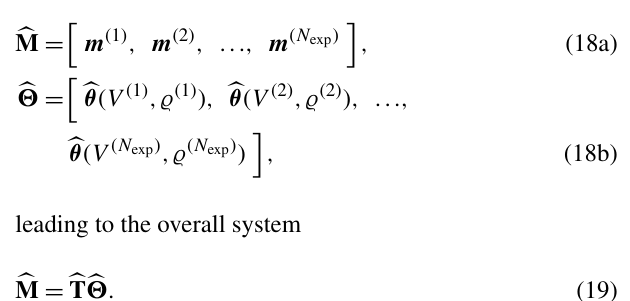
Figure 2. Behavior of two load sensitivities as functions of wind speed V and air density (cid:37) : sensitivity of out-of-plane 1 moment with respect to vertical shear κ v (a) and yaw misalignment φ (b) . The boundaries between regions II, II 1 red solid lines. The color indicates the value of the function, i.e., the elevation of the